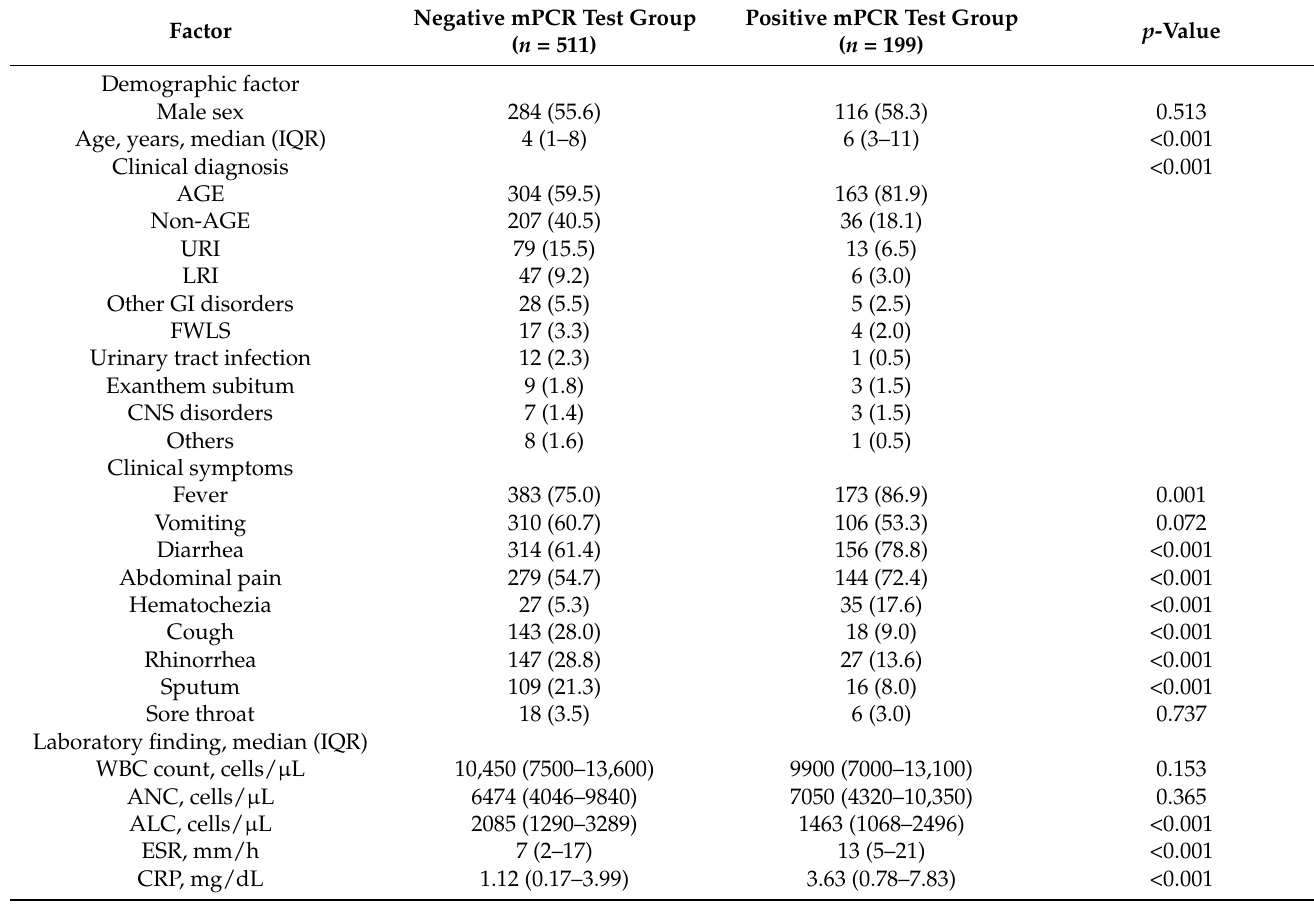
Table 2. Comparison between patients with positive and negative mPCR test